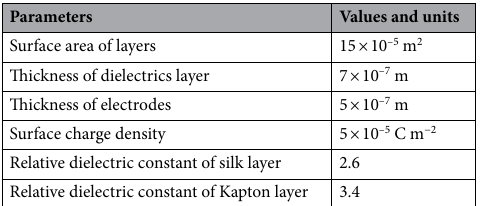
Table 1. Parameters used in the calculation of TENG’s output